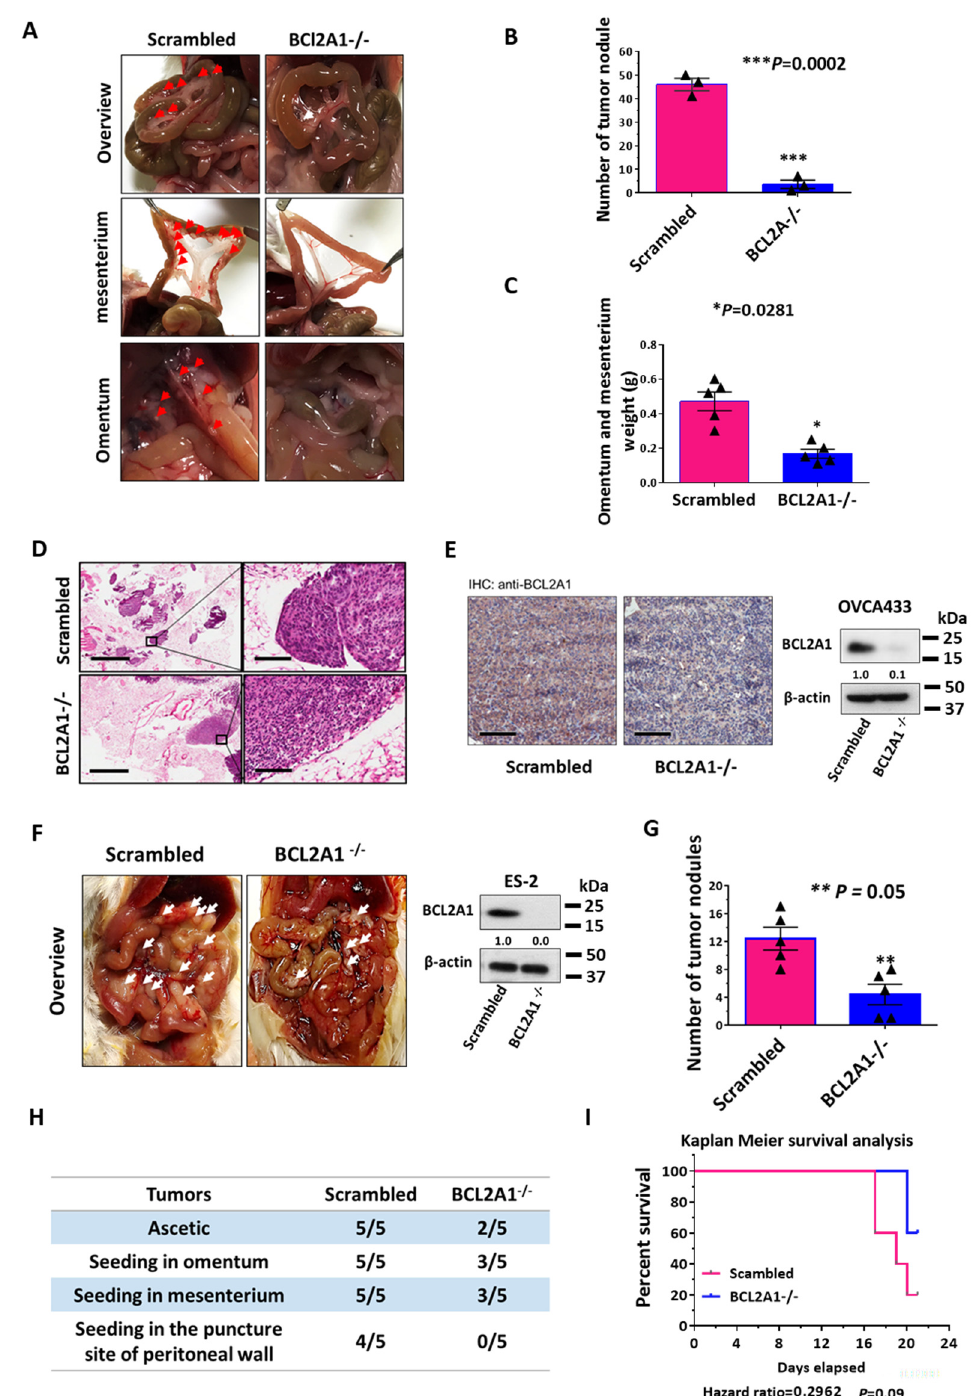
Figure 7. BCL2A1 promotes in vivo tumor dissemination of metastatic ovarian cancer cells. ( A ) The stereomicroscope examination showed that the number of tumor nodules formed by the OVCA433 cells with BCL2A1 − / − was much less than those formed by the scrambled control cells. The milky semi-translucent modules highlighted with white arrows represented the tumor nodules formed in mesenturium (upper and middle) and omentum (lower). ( B ) The comparison of the number of tumor nodules in scrambled control and BCL2A1 − / − OVCA433 cells. (*** p = 0.0002). ( C ) The comparison of the total tumor weight obtained in mesenterium and omentum of OVCA433 with BCL2A1 − / − and scrambled OVCA433 cells. (* p = 0.0281). ( D ). H&E staining of the excised tumor tissues from omentum and mesenterium. The large dark purple spots represented the tumor nodules seeded in the omentum and mesenterium. Cells with large hollows were fat cells. The small homogenous pink-colored spots were the blood vessels of the omentum and mesenterium. (Scale bar: 1 mm (left) and 100 μ m (right)). ( E ) IHC staining confirmed that BCL2A1was barely expressed in the tumor nodules that were formed by BCL2A1 − / − OVCA433 cells (Scale bar: 100 μ m). ( F ) Representative pictures showed tumor nodules formed by BCL2A1 − / −